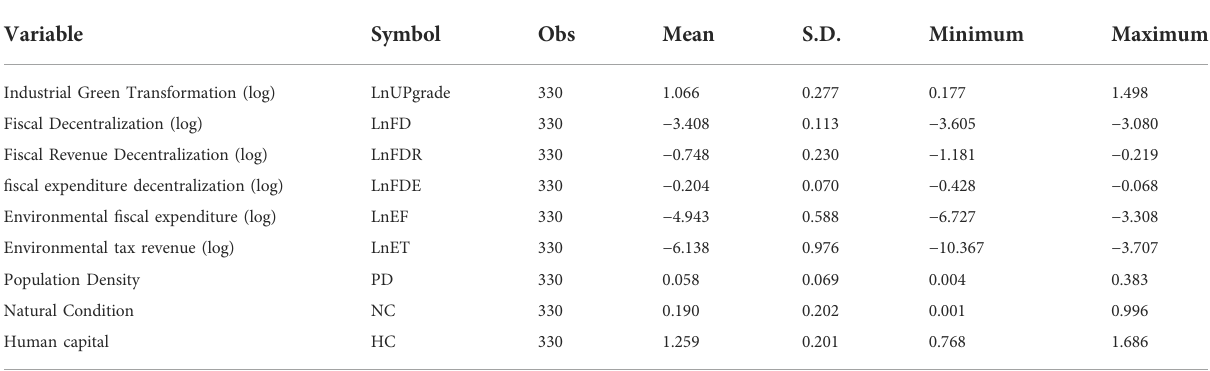
TABLE 3 Descriptive statistics of